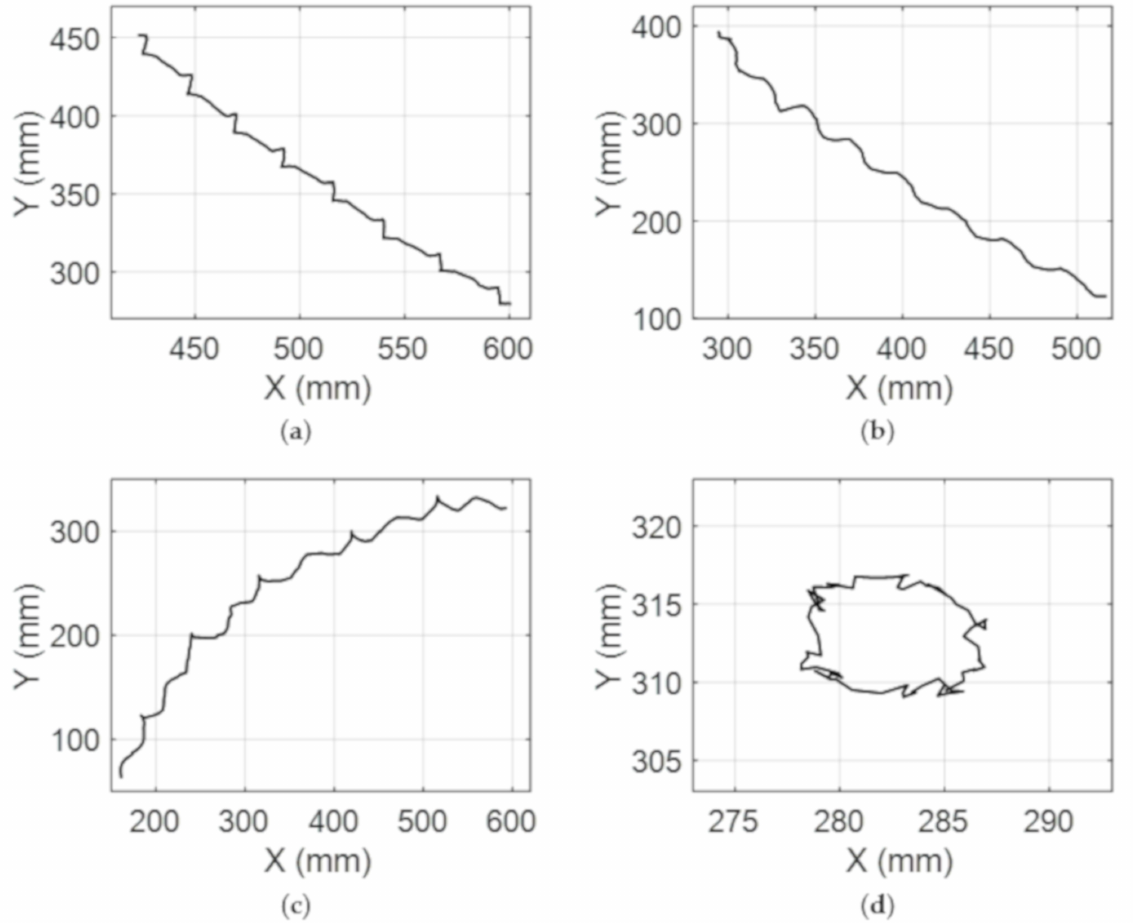
Figure 18. The trajectories of the hexapod robot in the experiments with four different gaits: ( a ) the wave gait; ( b ) the tetrapod gait; ( c ) the tripod gait; ( d ) the self-turning